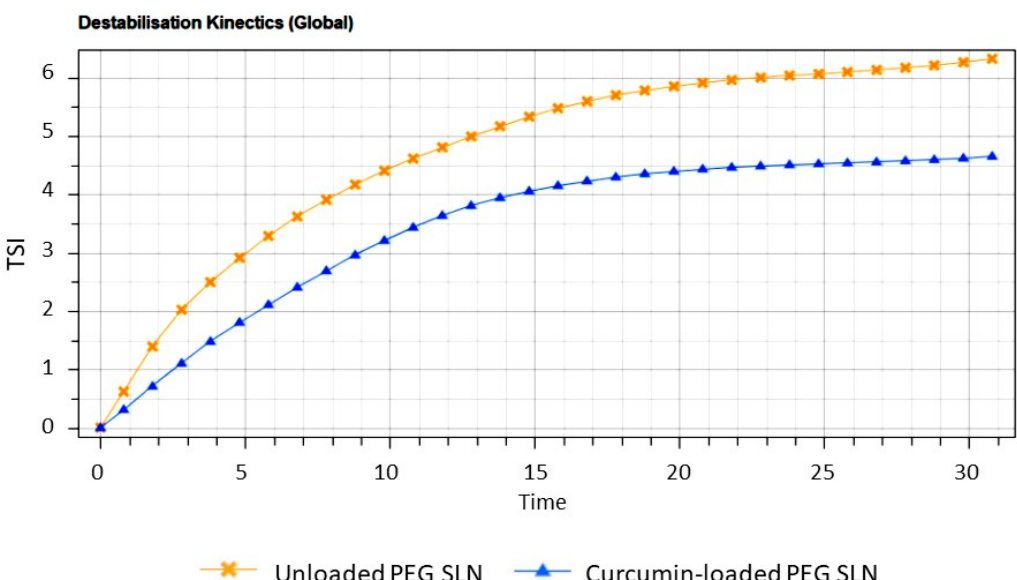
Figure 5. Destabilization kinetics in terms of Evolution of Turbiscan ® Stability Index (TSI) of blank and CUR-pSLNs stored for 30 days in TAGS at 25 °C.